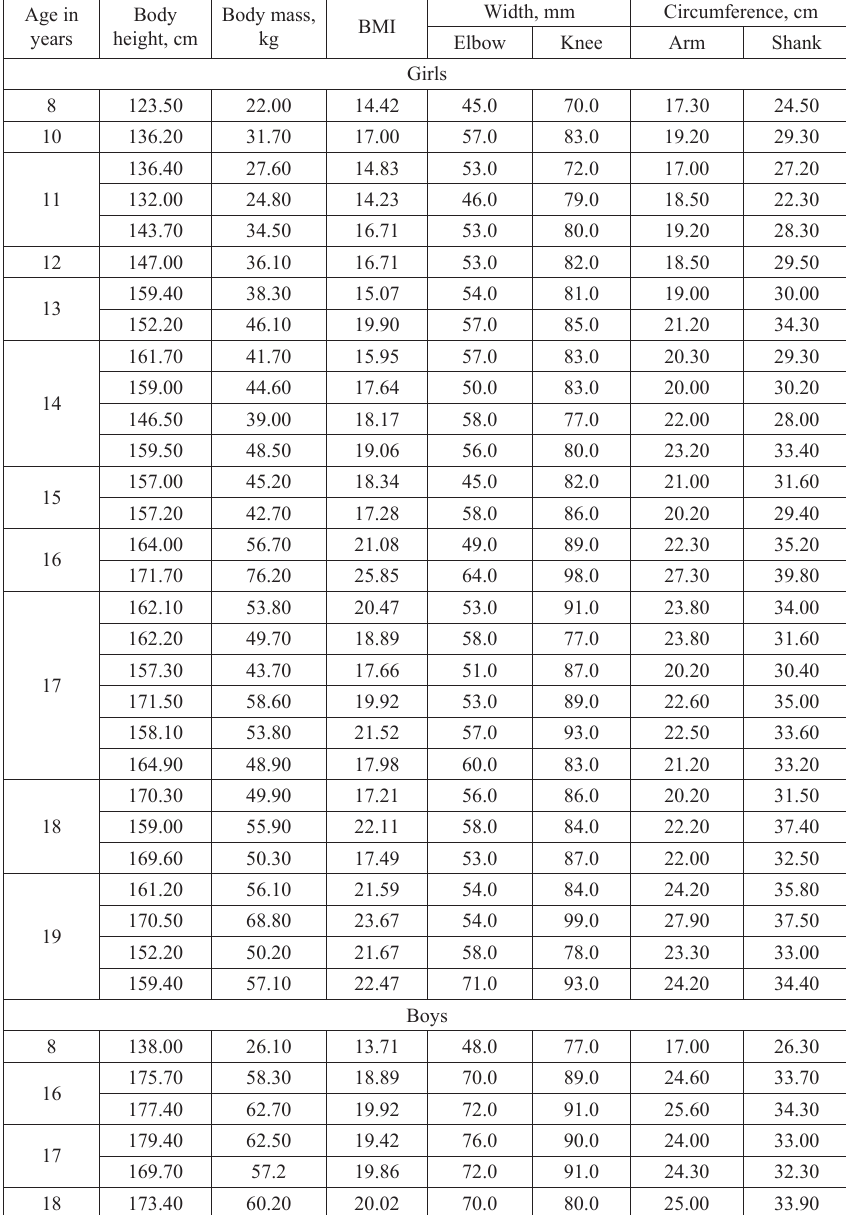
Table 3. Somatic parameters of ru- ral girls and boys with structural